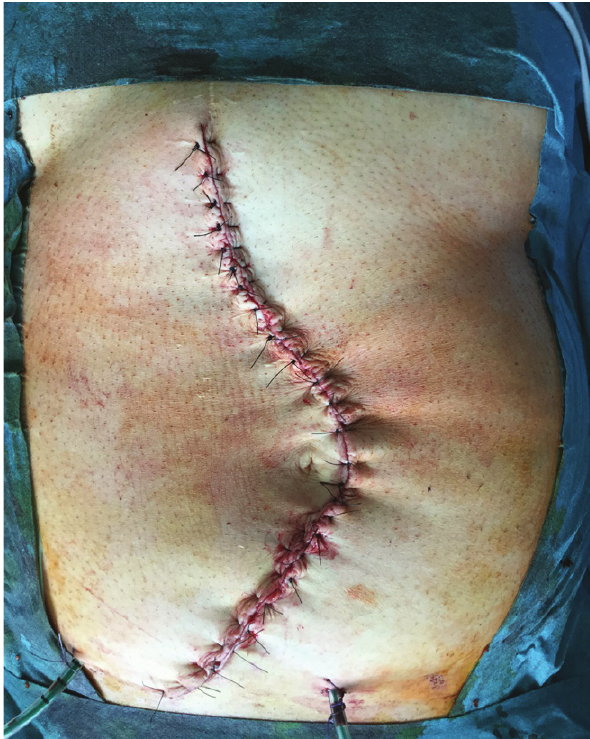
Figure 5: Anterior abdominal wall after wound closure